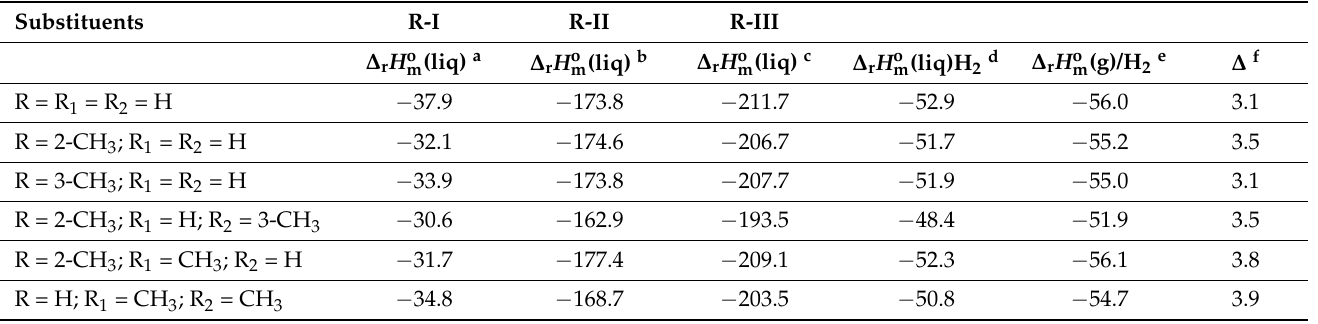
Table 9. Calculation of the liquid-phase reaction enthalpies, ∆ r H o m (liq), of the hydrogenation of indole